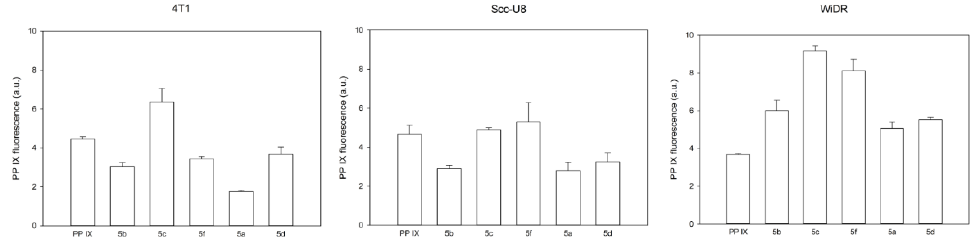
Figure 2. Cellular uptake of PpIX and PpIX derivatives, 5a – d and 5f .